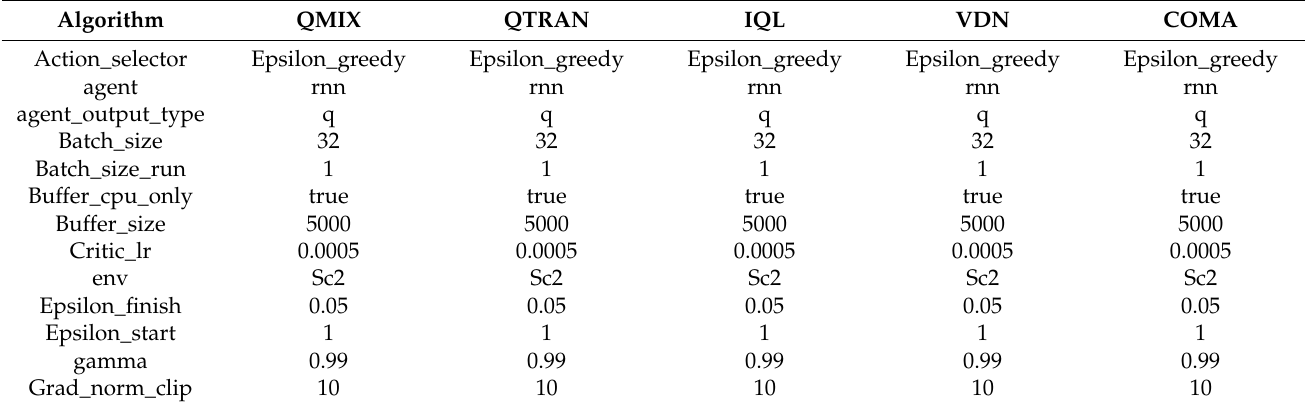
Table 1. The parameters of the algorithm.